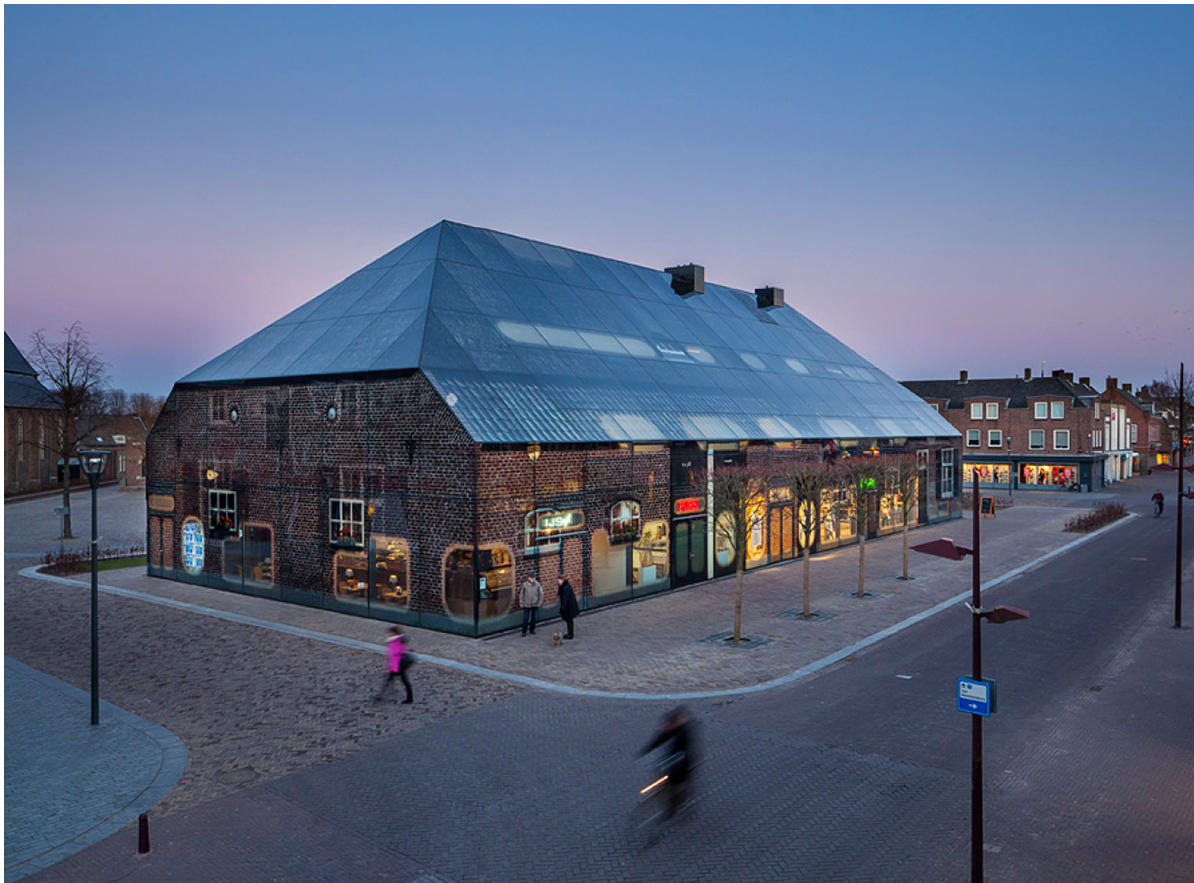
Figure 11. Reflections of the city landscape at Glass Farm in Schijndel. Photo: © Daria Scagliola and Stijn Brakkee.